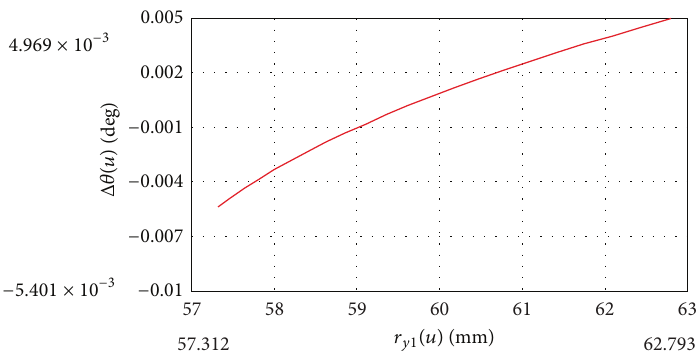
Figure 6: Deviation between two profiles at tooth